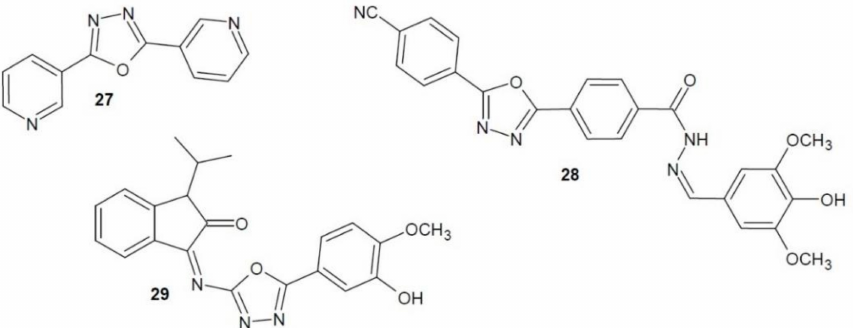
Figure 12. 1,3,4-Oxadiazole derivatives with activity of thymidine phosphorylase inhibitors (part 1). Bajaj et al. (2018) obtained a number of 5-(4-chlorophenyl)-1,3,4-oxadiazole-2-thione